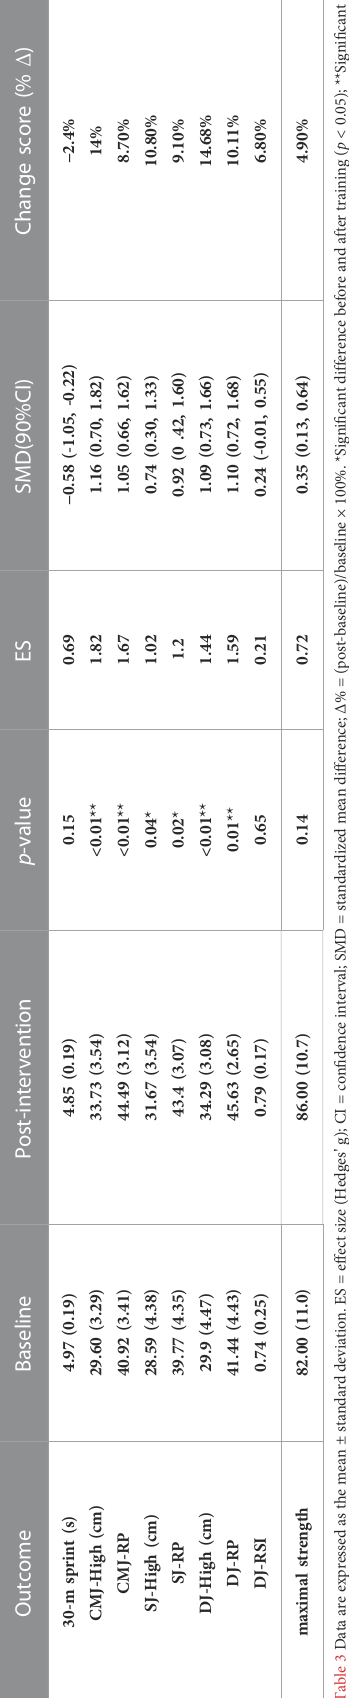
The PN group underwent 6 weeks of power-based pneumatic resistance squat training. A 0.01-s reduction in 30 m sprint time was found ( p = 0.99, 0.2%, ES < 0.01), and no signi fi cant differences were observed before and after training when linear velocity analysis was performed